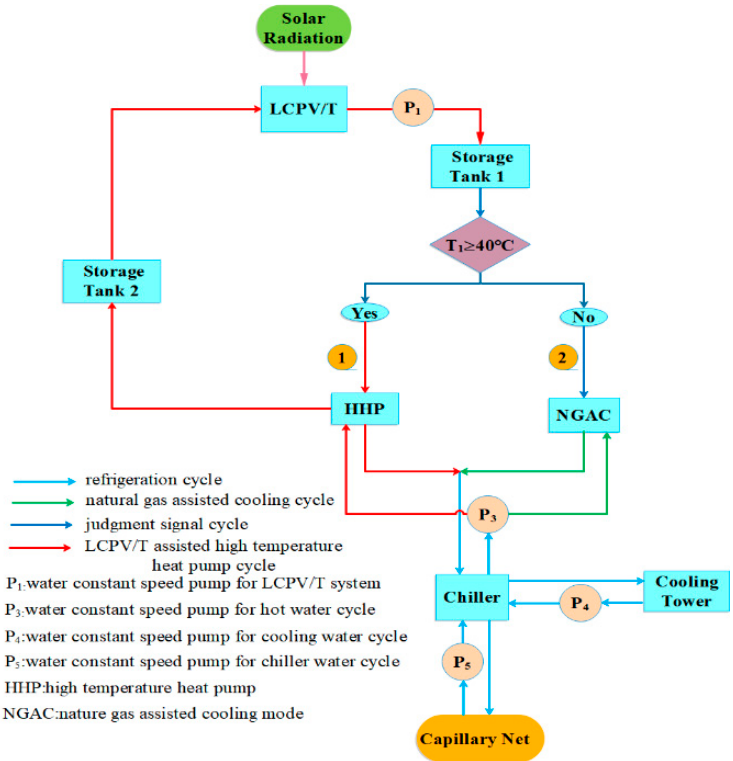
Figure 3. Schematic diagram of the NG-LCPV/T-TG system in cooling mode.